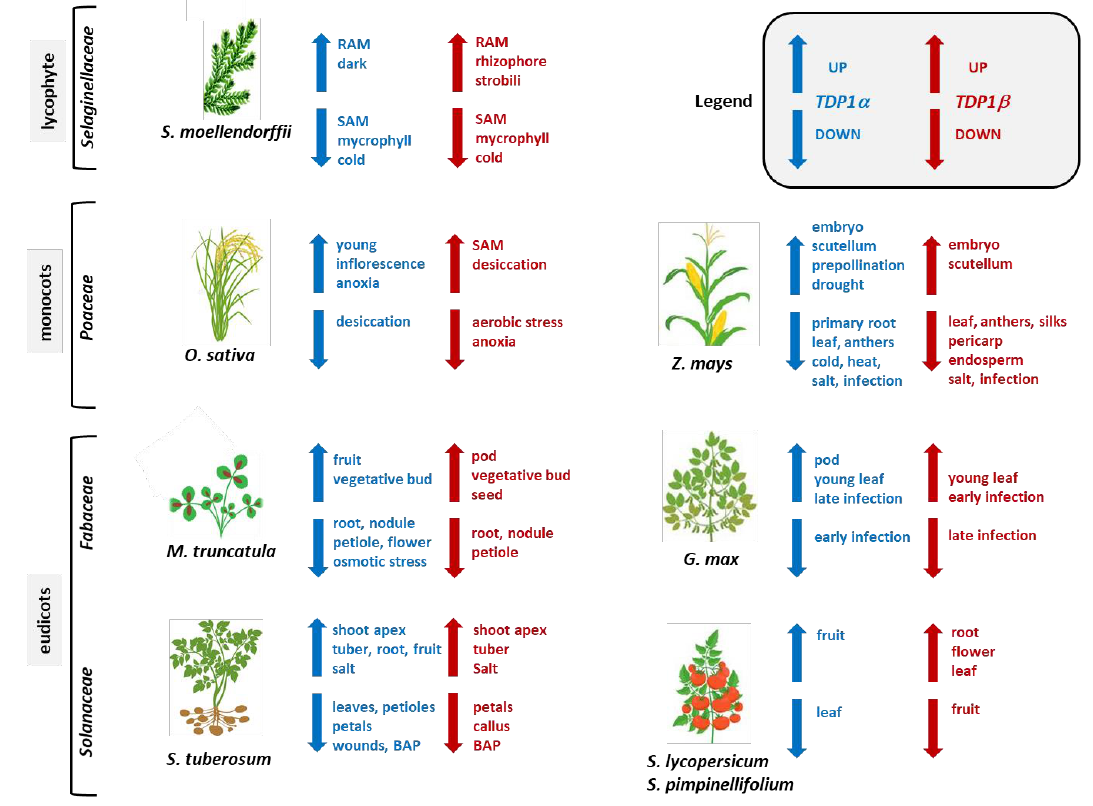
Figure 8. Schematic representation of TDP1 α and TDP1 β gene expression patterns in representative lycophytes, monocots, and dicots. TDP1 α expression is given in blue while TDP1 β is given in red. Arrows indicate increased or decreased accumulation, respectively.